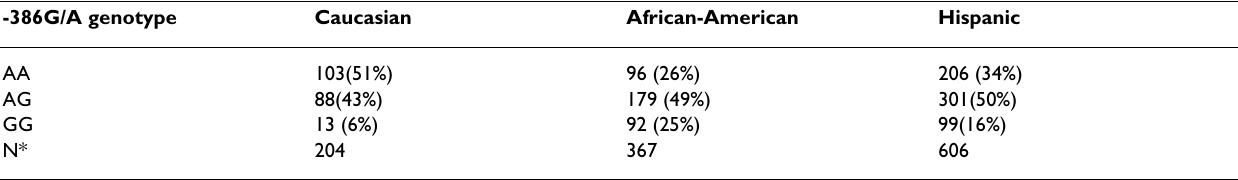
Table 6: Genotype frequencies of the -386G/A SNP in three ethnic groups -386G/A